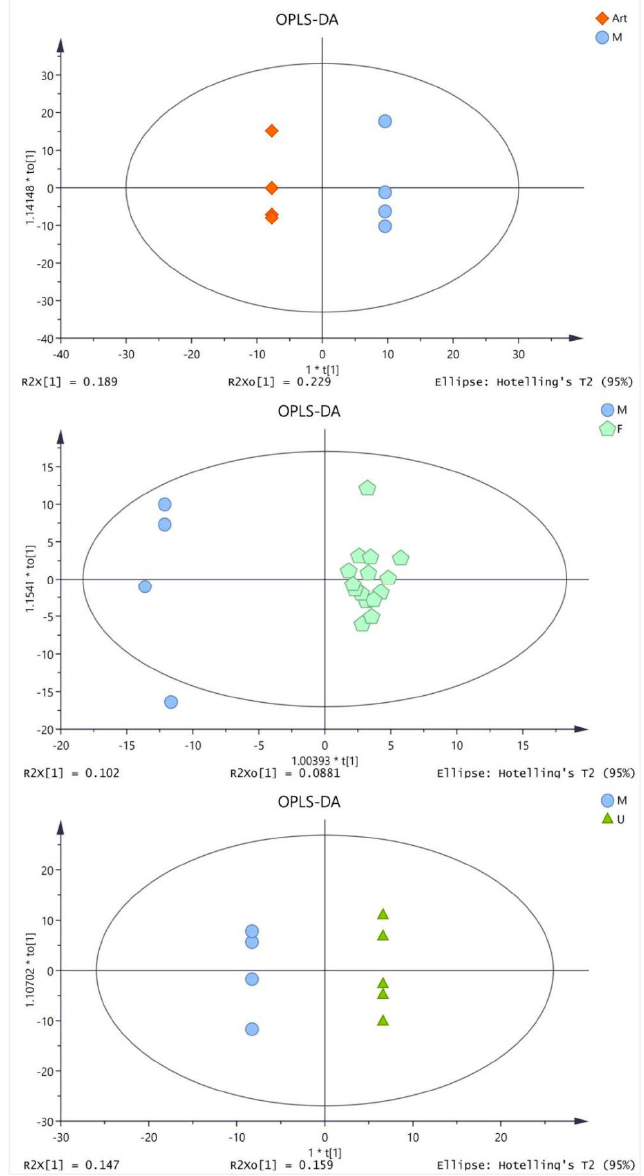
Figure 3. Orthogonal partial least squares discriminant analysis (OPLS-DA) score plots based on the gas chromatography time-of-flight mass spectrometry (GC/TOFMS) data for the model (M) groups vs. artesunate (ART) group (20 mg/kg); ursolic acid (U) group (20 mg/kg) and combination (F) group (artesunate 20 mg/kg + ursolic acid 20 mg/kg).